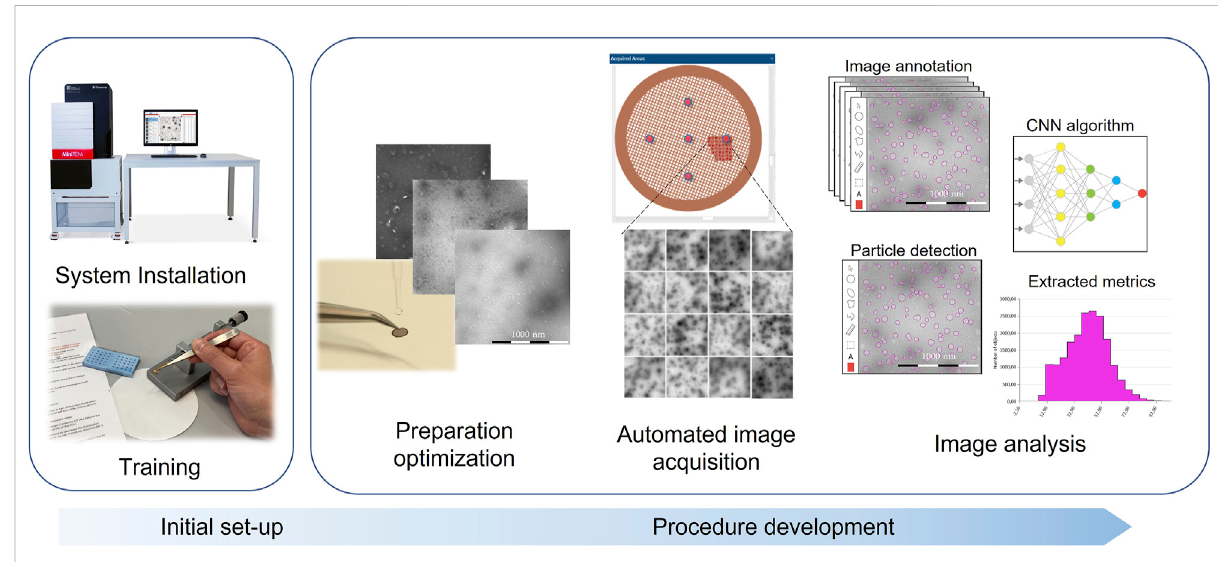
Development process for implementation of TEM work fl ow. After an initial set-up consisting of the system installation and personnel training, thepreparationmethodisoptimizedbytestingdifferentstains,supportsandpreparationconditions.Thepreparedspecimensarethenimagedusing an automated dataacquisition to screen several gridareasand ensureagood representativity ofthesample. Finally,theacquired imagesare fedinto the CNN algorithm, trained via manual image annotation prior to the automated analysis, the resulting detection can be visually evaluated, and the data used for specimen evaluation. This whole process can be implemented into a validation